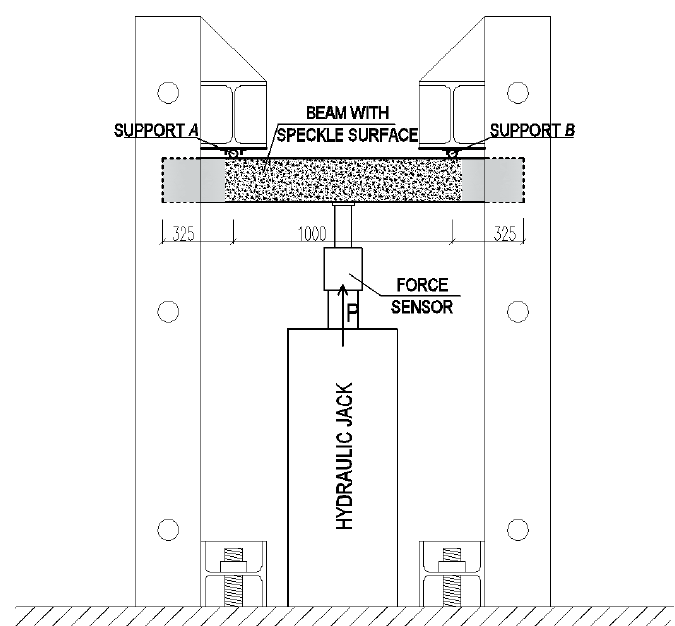
Figure 6. Schematic of experimental setup [44].